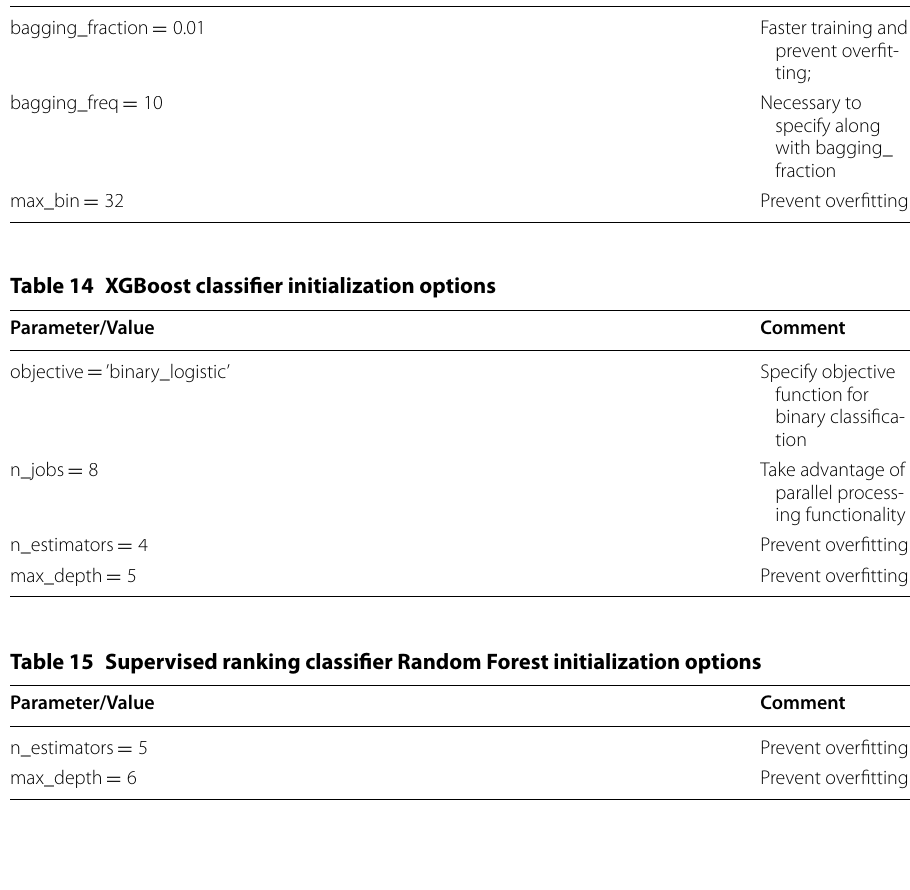
Table 13 LightGBM classifier initialization options Parameter/Value